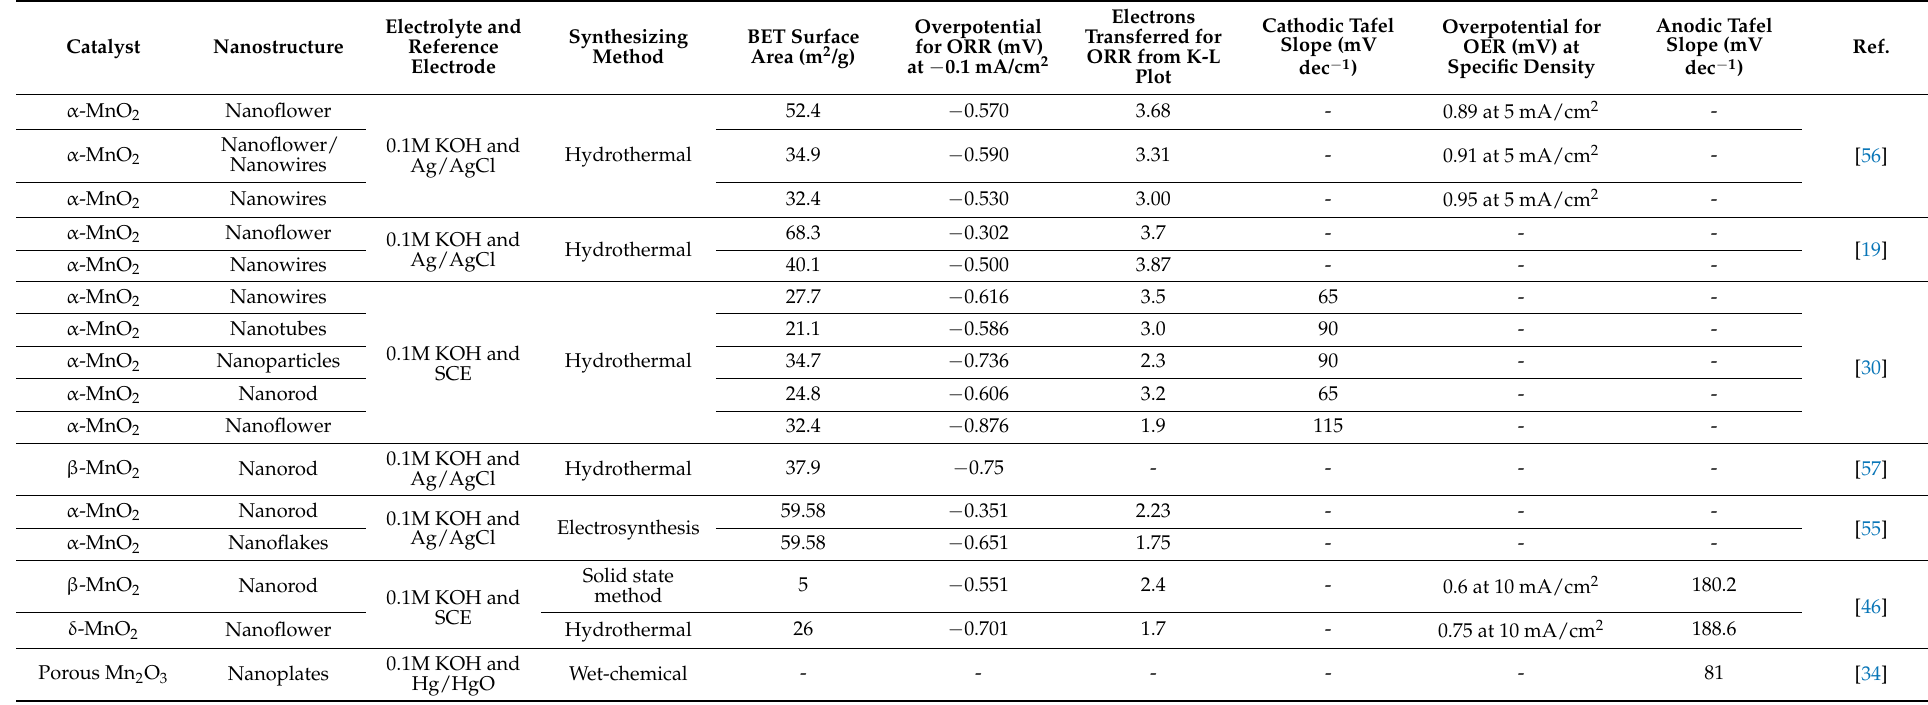
Table 2. Summary of the ORR and OER parameter of recently reported nanostructure manganese oxide catalyst, adapted from